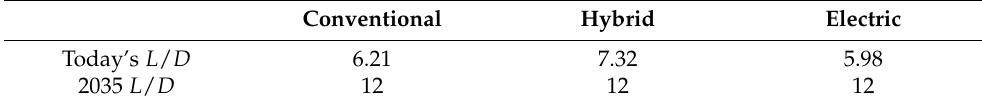
Table 4. Other specifications of the air taxis